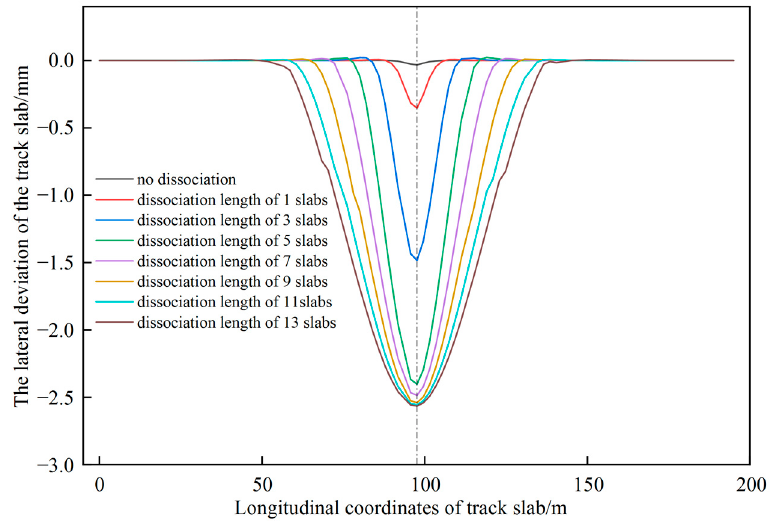
Figure 5. Track deviation curves of different dissociation lengths under single point jacking.